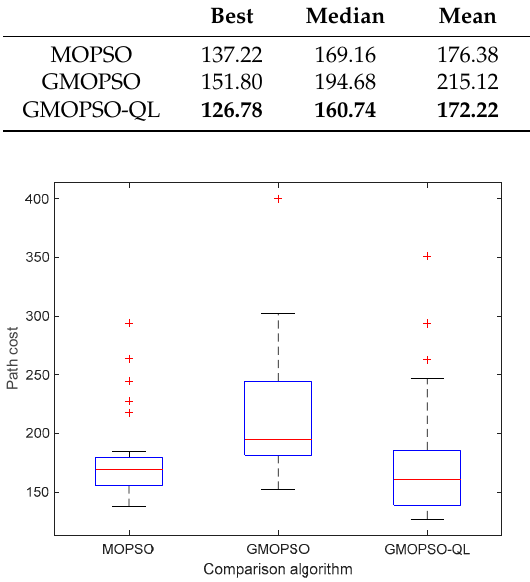
Figure 7. The boxplot of statistical results in Case 1.